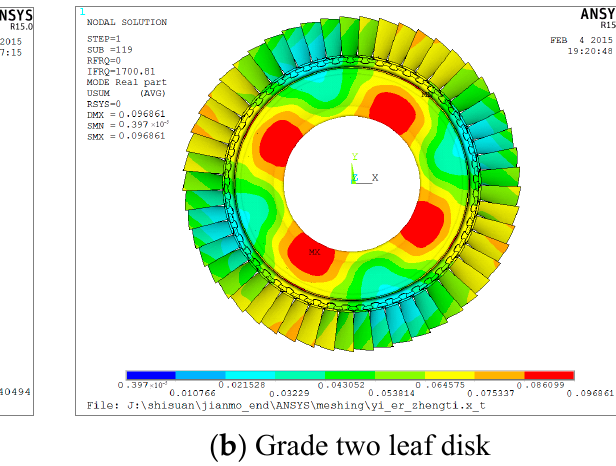
Figure 34. Mode 115.